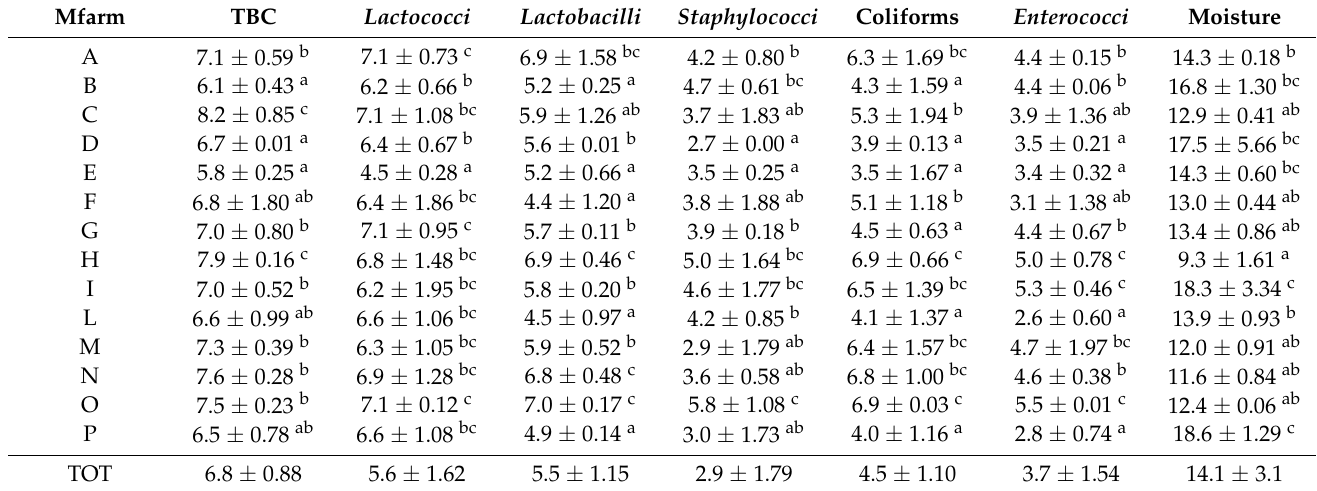
Table 1. Microbiological characteristics and moisture of traditional mountain butter (TMB) samples produced in the Malga, in the Trentino Alpine region. Abbreviation: TBC, total bacteria counts. Plate counts (Log colony forming units (CFU)/g) and moisture data (g/100 g) are expressed as the mean ± SD ( n = 3 biological replicates). For each column, the bacterial count, and moisture values with a, b, and c superscripts are significantly different ( p < 0.05, one-way Anova with post-hoc Tukey HSD). Lactococci Lactobacilli Staphylococci Coliforms Enterococci